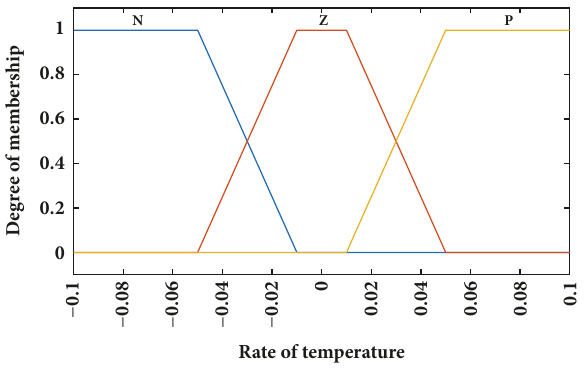
Figure 11: MFs of change in Δ T. Table 2: MFs of zone temperature difference.